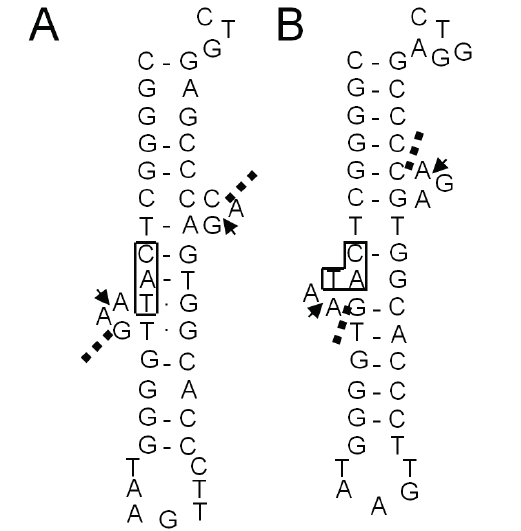
Figure 8. The BHB-like structure in the unspliced form of tRNA Met (CAU-1) of S. tokodaii strain7 [15]. Only the anticodon arm and extra loop regions are shown. ( A ) The structure predicted by Marck and Grosjean [19]; ( B ) the structure inferred by in vitro cleavage of the intron with recombinant S. tokodaii EndA [15]. The exon-intron borders determined by the biochemical study [15] are indicated by arrowheads. Dashed lines in ( A , B ) show the cleavage sites predicted by Marck and Grosjean [19]. The anticodon sequences are